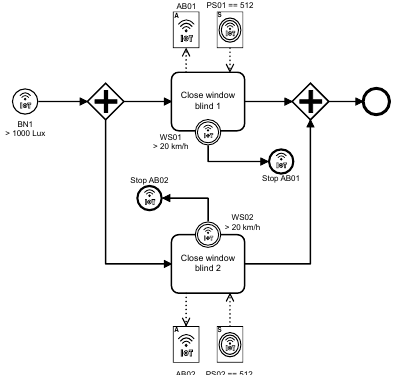
Figure 18. Process to control the brightness in a smart